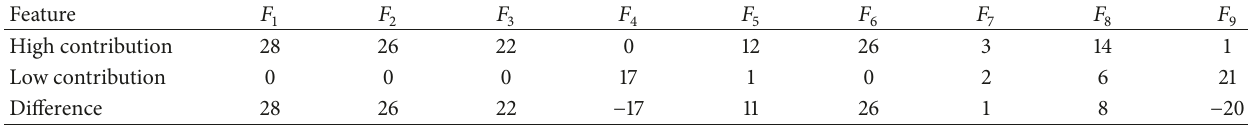
Table 3: Statistical results based on compressed stochastic